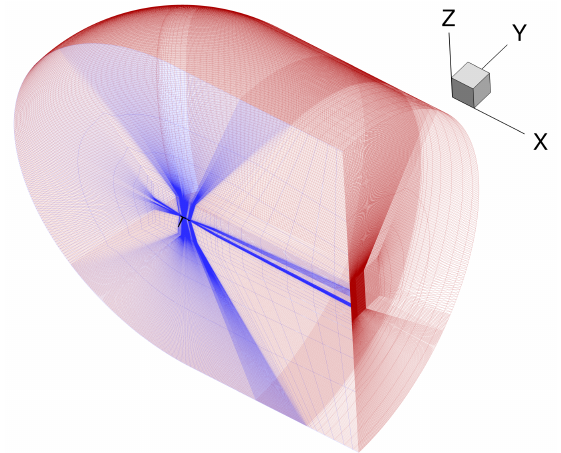
Figure 10. Discretized computational domain of the FLEXOP half model with the medium resolution.